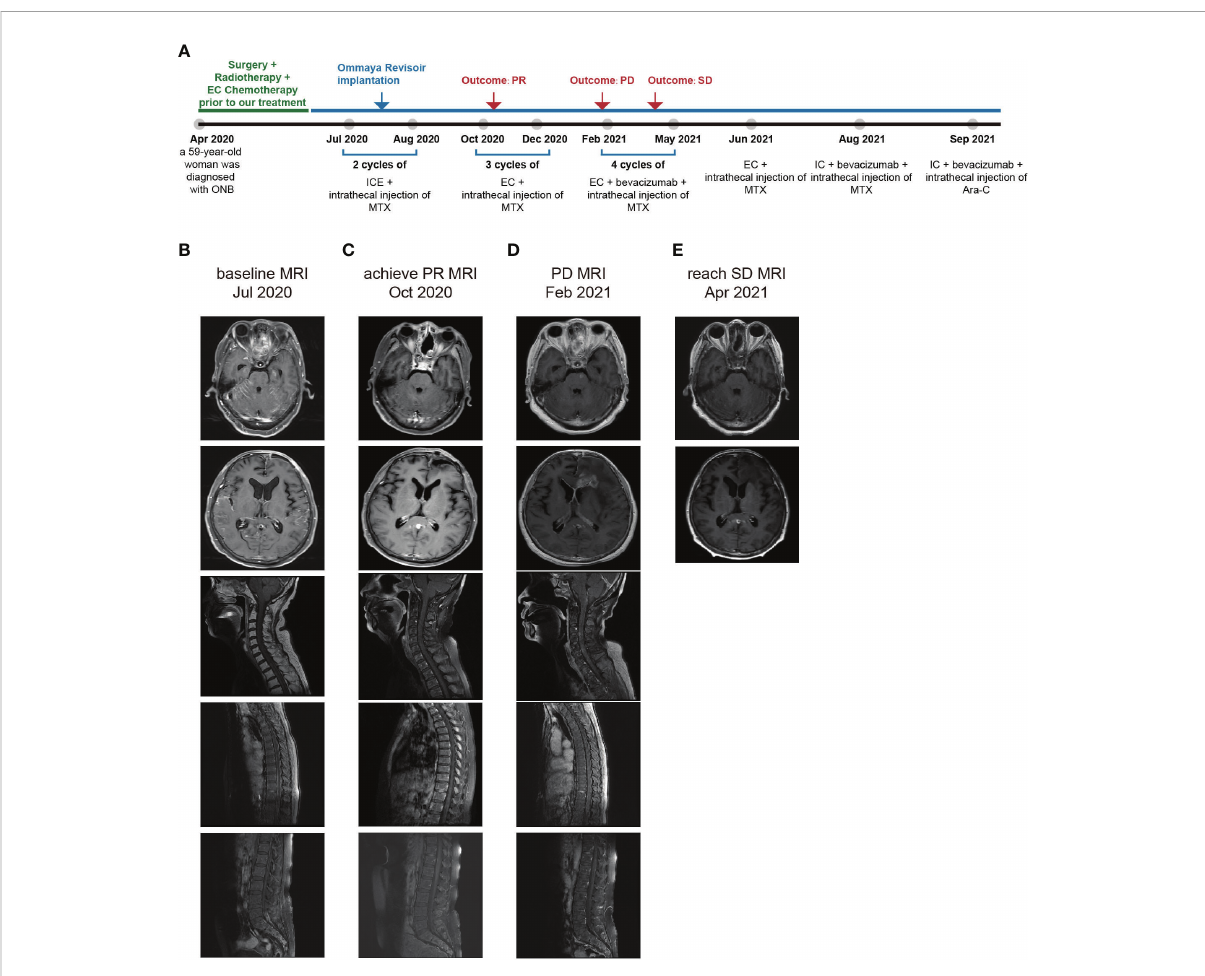
FIGURE 2 (A) Timeline depicting diagnoses, changes in treatment, duration, and outcome. (B) MRI at the time admitted to our hospital. (C) MRI when achieving the PR. (D) MRI at PD. (E) MRI when reaching